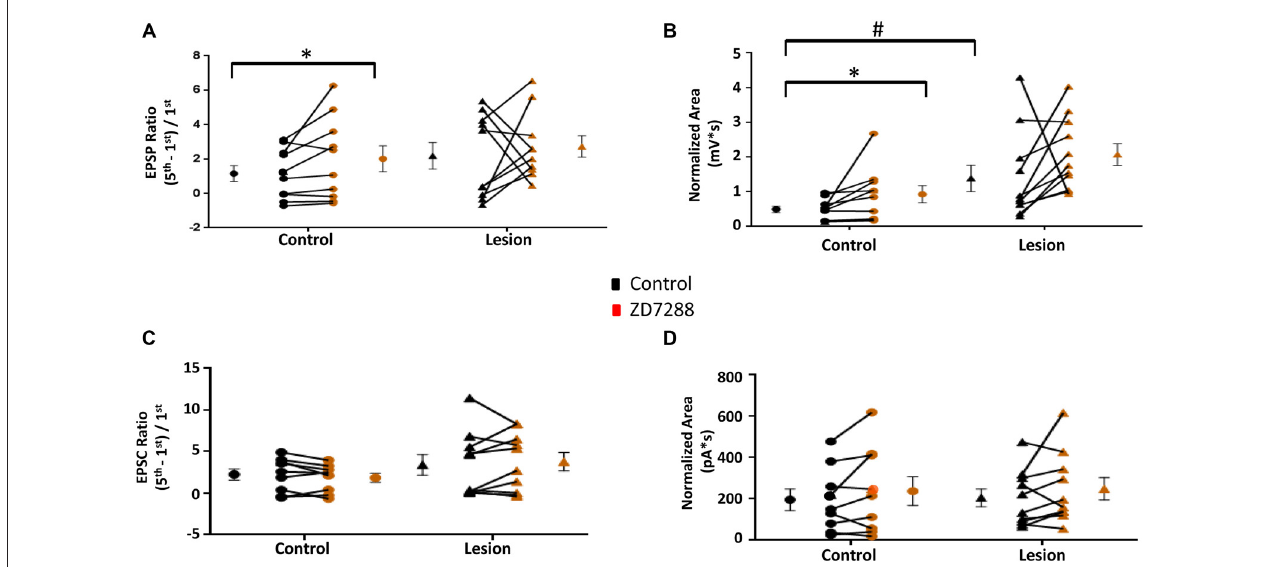
FIGURE 6 | EPSP ratios in L5 accommodating interneurons are increased in control but not freeze lesioned animals following HCN blockade. (A) HCN channel inhibition increased amplitude ratios in control but not freeze lesioned animals. No difference was seen in pre-drug ratios between control and lesion